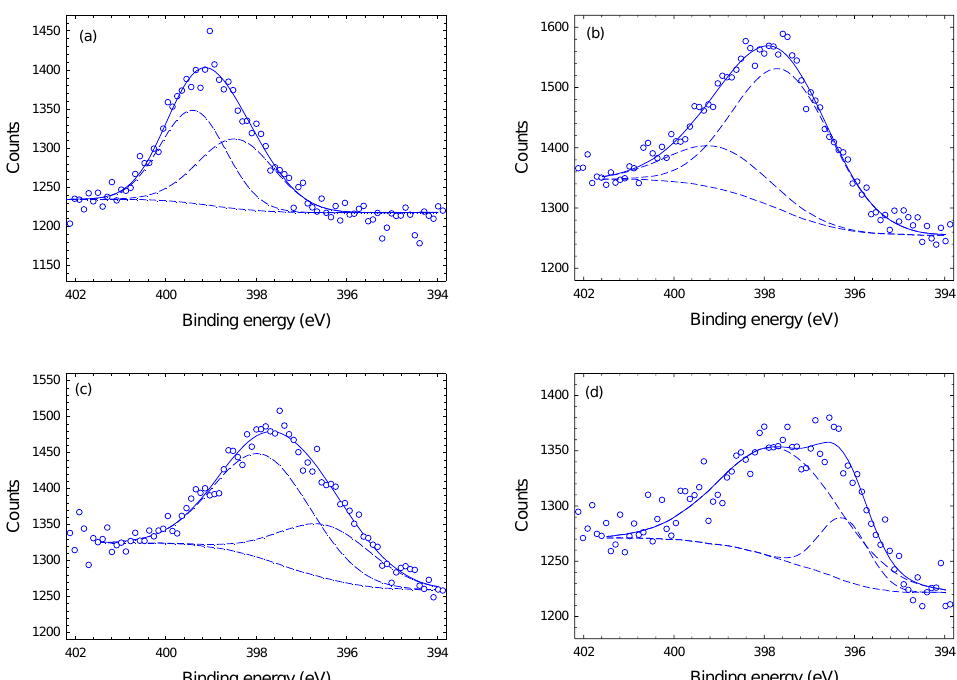
Figure 7. Deconvoluted N-1s XPS spectra of Ti x -Cu y N z film at different depths: ( a ) at the surface, ( b ) 1 µ m ( c ) 3 µ m and ( d ) 4 µ m.